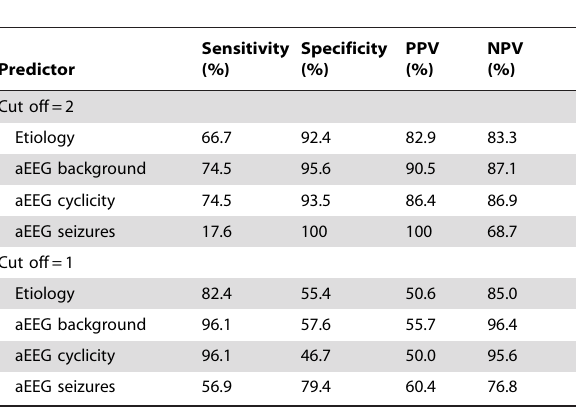
Table 4. The predictive value of aEEG features and etiology for severely abnormal prognosis in neonates with seizures.